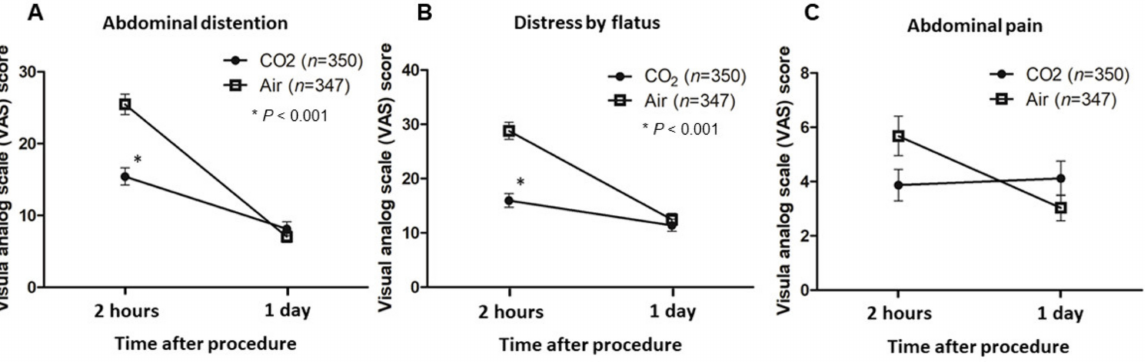
Figure 2. The change over time in the visual analog scale (VAS) score from 2 h to 1 day after the procedure. ( A ) VAS scores for abdominal distension. The VAS score for CO 2 insufflation was significantly lower than that for air insufflation (15.4 vs. 25.5; p < 0.001) at 2 h, but not at 1 day after the procedure. ( B ) VAS scores for distress due to flatus. The VAS score for CO 2 insufflation was significantly lower than that for air insufflation at 2 h after the procedure (16.0 vs. 28.8; p < 0.001). ( C ) VAS scores for abdominal pain. There was no significant difference in abdominal pain between the two groups.